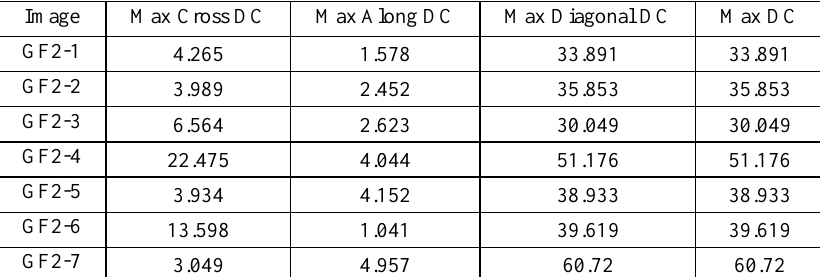
Table 6. The maximum deviation coefficients of GF2 dataset. The deviation coefficients in the table have been multiplied by 10 4 . Image Max Cross DC